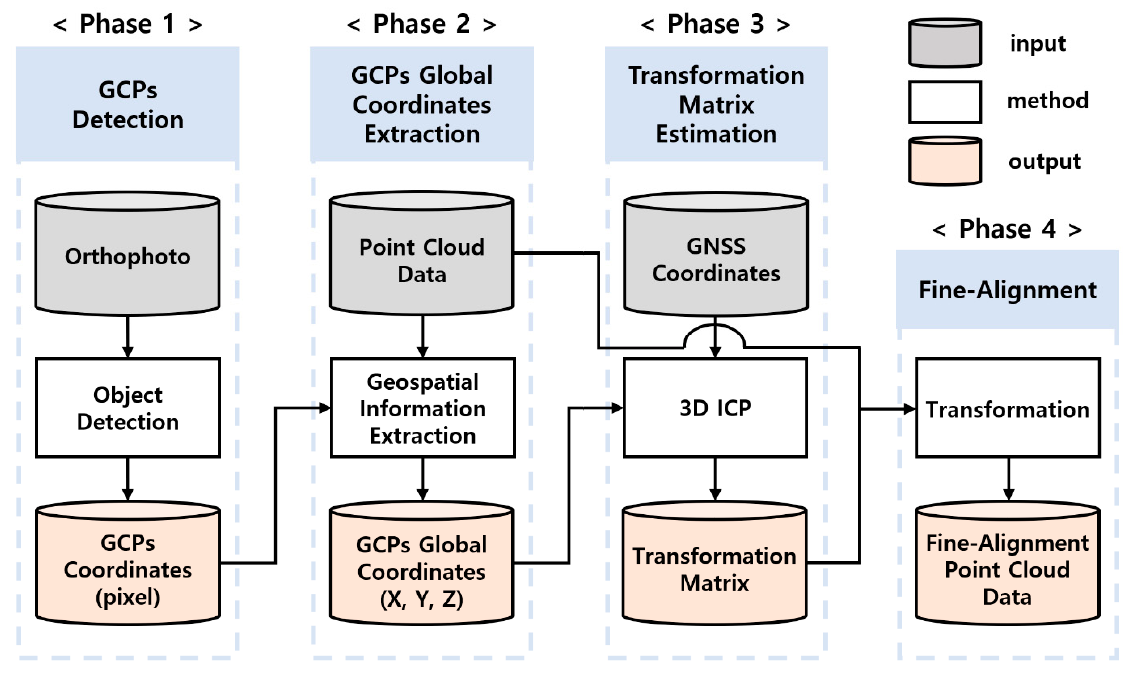
Figure 1. GCP-based automated fine alignment framework.